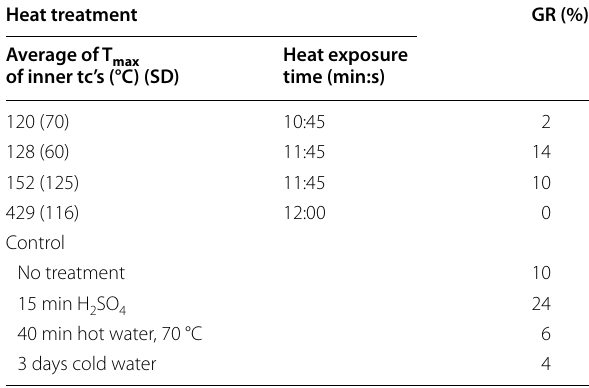
Table 1 Germination rates (GR) of A. digitata Table 2 Germination rates (GR) of A.